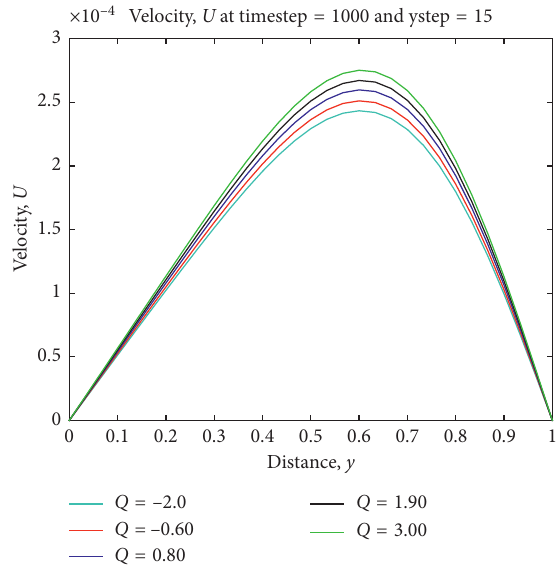
Figure 9: Graph of effects of heats source/sink parameter on primary velocity profile u .